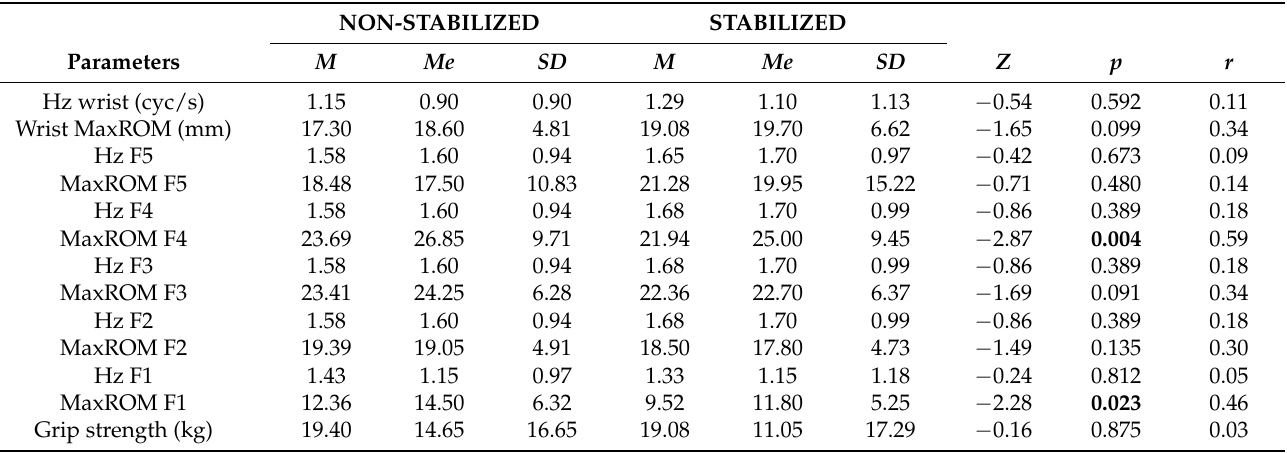
Table 5. Comparison of the results of parameters in the stabilized and stabilized position for the 46–60-year-old age group of people after stroke.